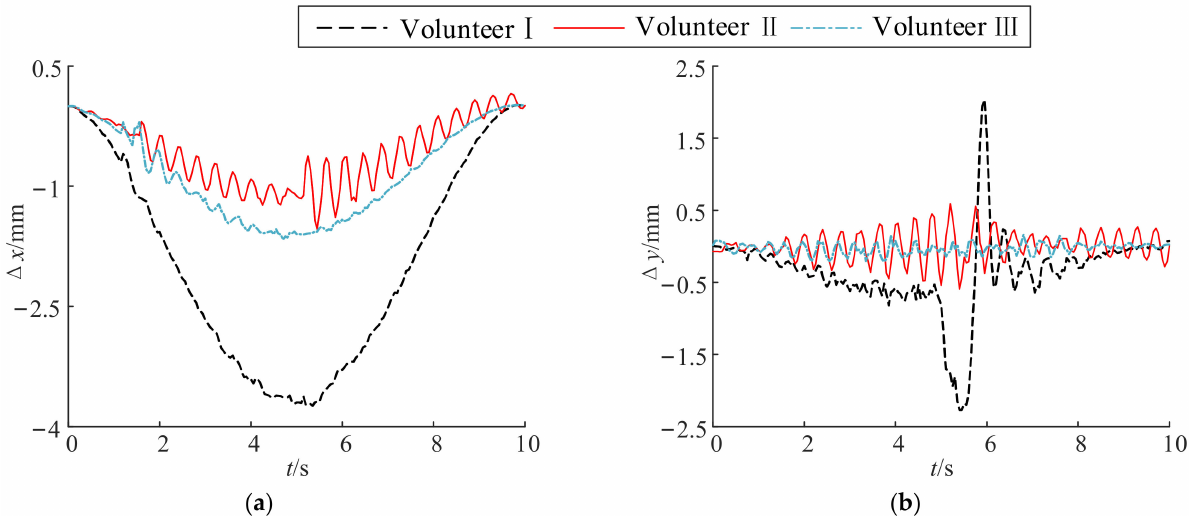
Figure 15. The deviation of x and y values over time. ( a ) The deviation of the terminal x value. ( b ) The deviation of the terminal y